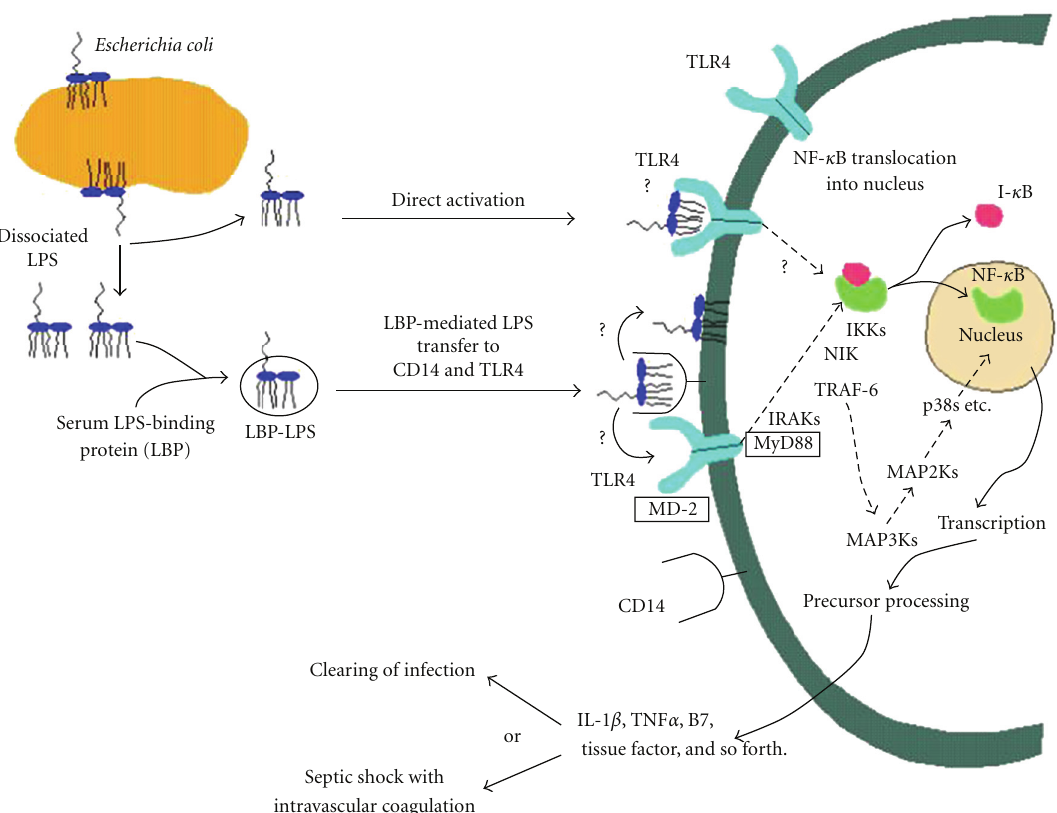
Figure 1: Lipopolysaccharide (endotoxin) signaling pathway. (Used with permission from